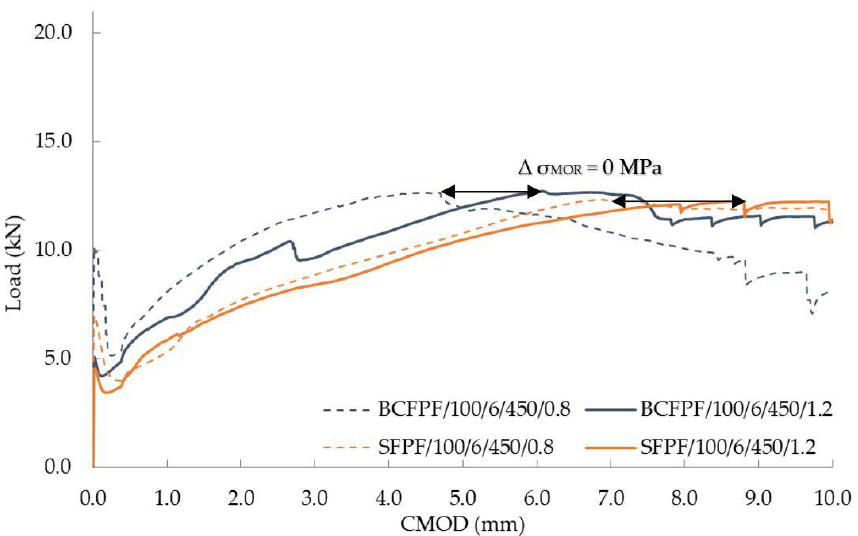
Figure 17. Load—CMOD (crack mouth opening displacement) relationship graphs for fiber-reinforced soil-cements with no σ MOR di ff erential stress